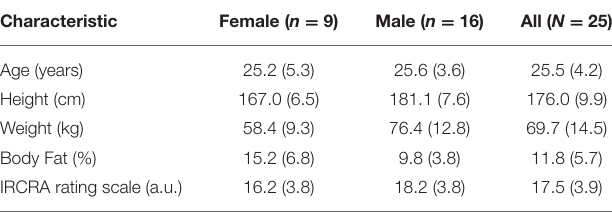
TABLE 1 | Participant characteristics, means with standard deviations